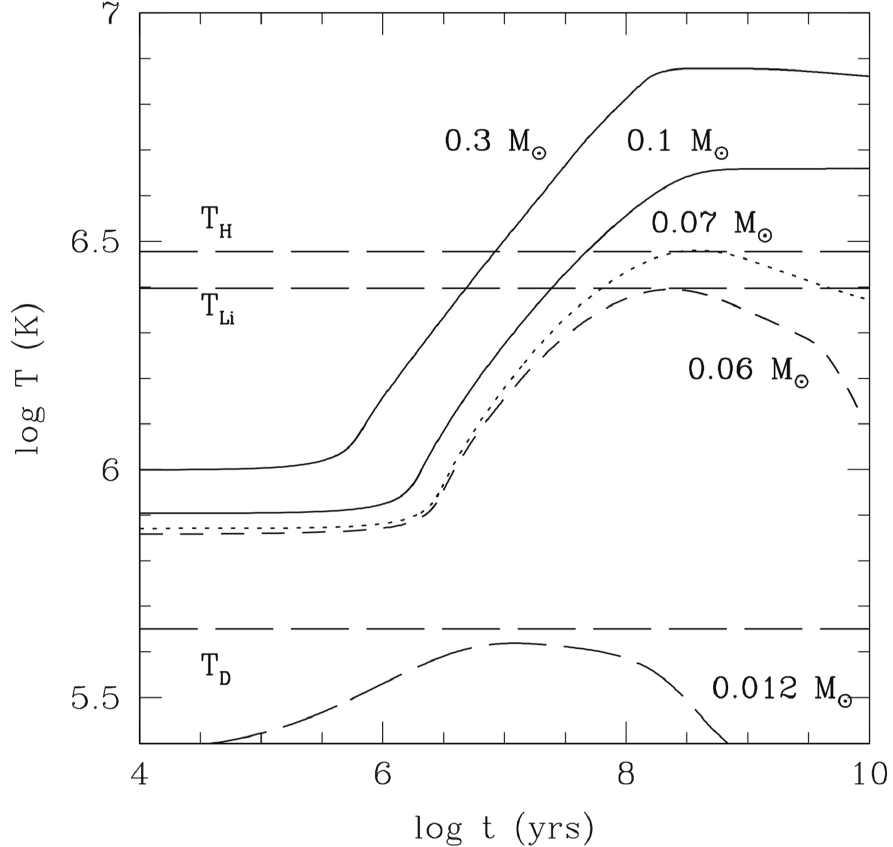
Figure 1. Central temperature of stars, brown dwarfs and “planetary-mass objects” as a function of age for 0.3, 0.1, 0.07, 0.06 and 0.012 M sol , from top to bottom. Dashed horizontal lines mark the burning temperatures for 1 H hydrogen, 7 Li lithium and 2 H deuterium. “Planetary-mass objects” never reach a central temperature for deuterium fusion. Reproduced with permission from [66].